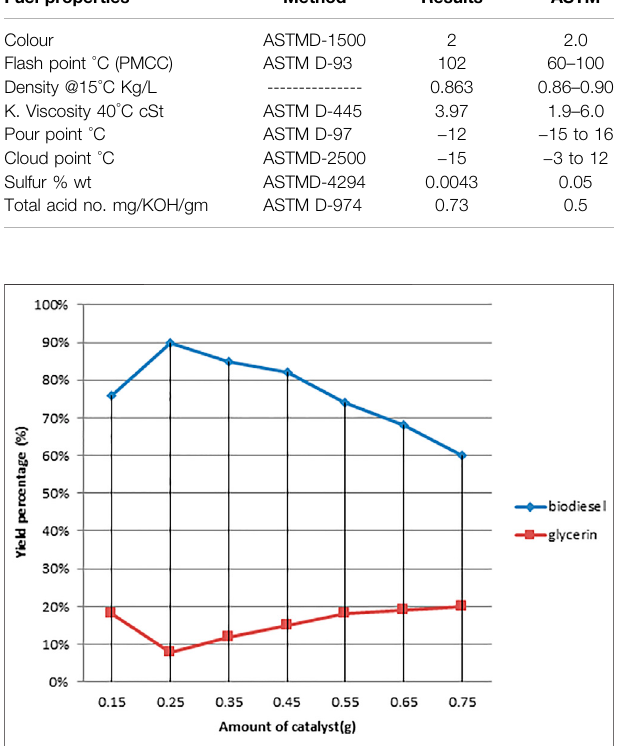
FIGURE 5 | Effect of variation in catalyst (KOH) concentration on the Dodonaea biodiesel production.